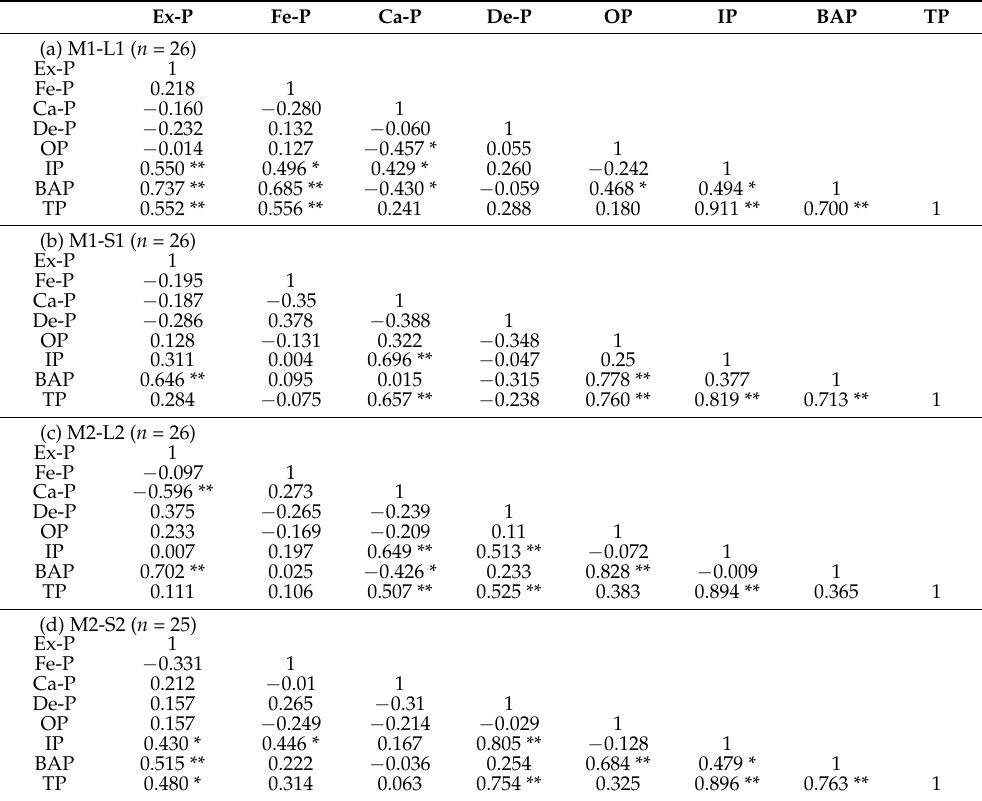
Table 4. Pearson’s correlations between phosphorus fractions from the sediment cores of Ximen Island mangrove. Ex-P